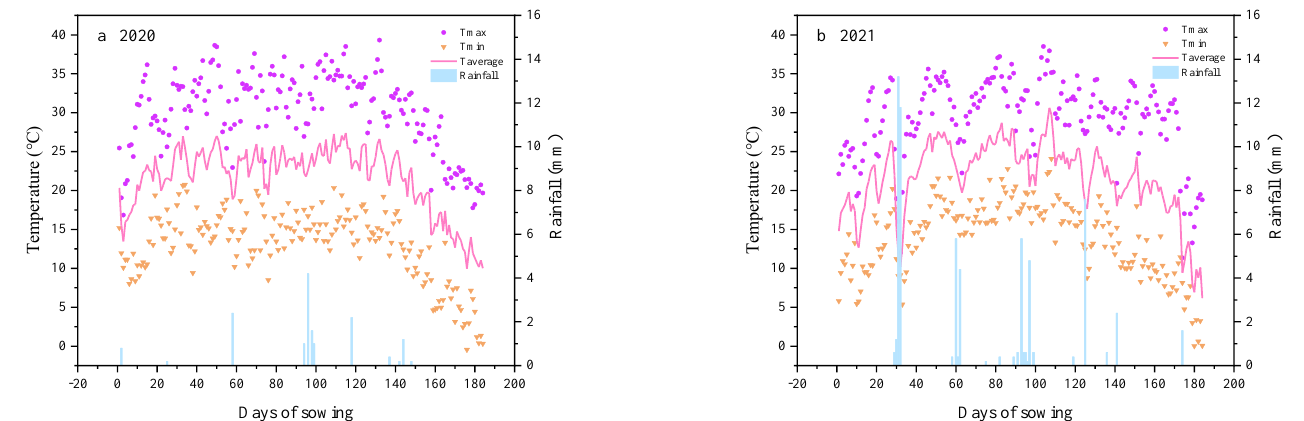
Figure 3. The maximum temperature (T max ), minimum temperature (T min ), average temperature (T average ) and rainfall during ( a ) 2020 and ( b ) 2021 seasons.